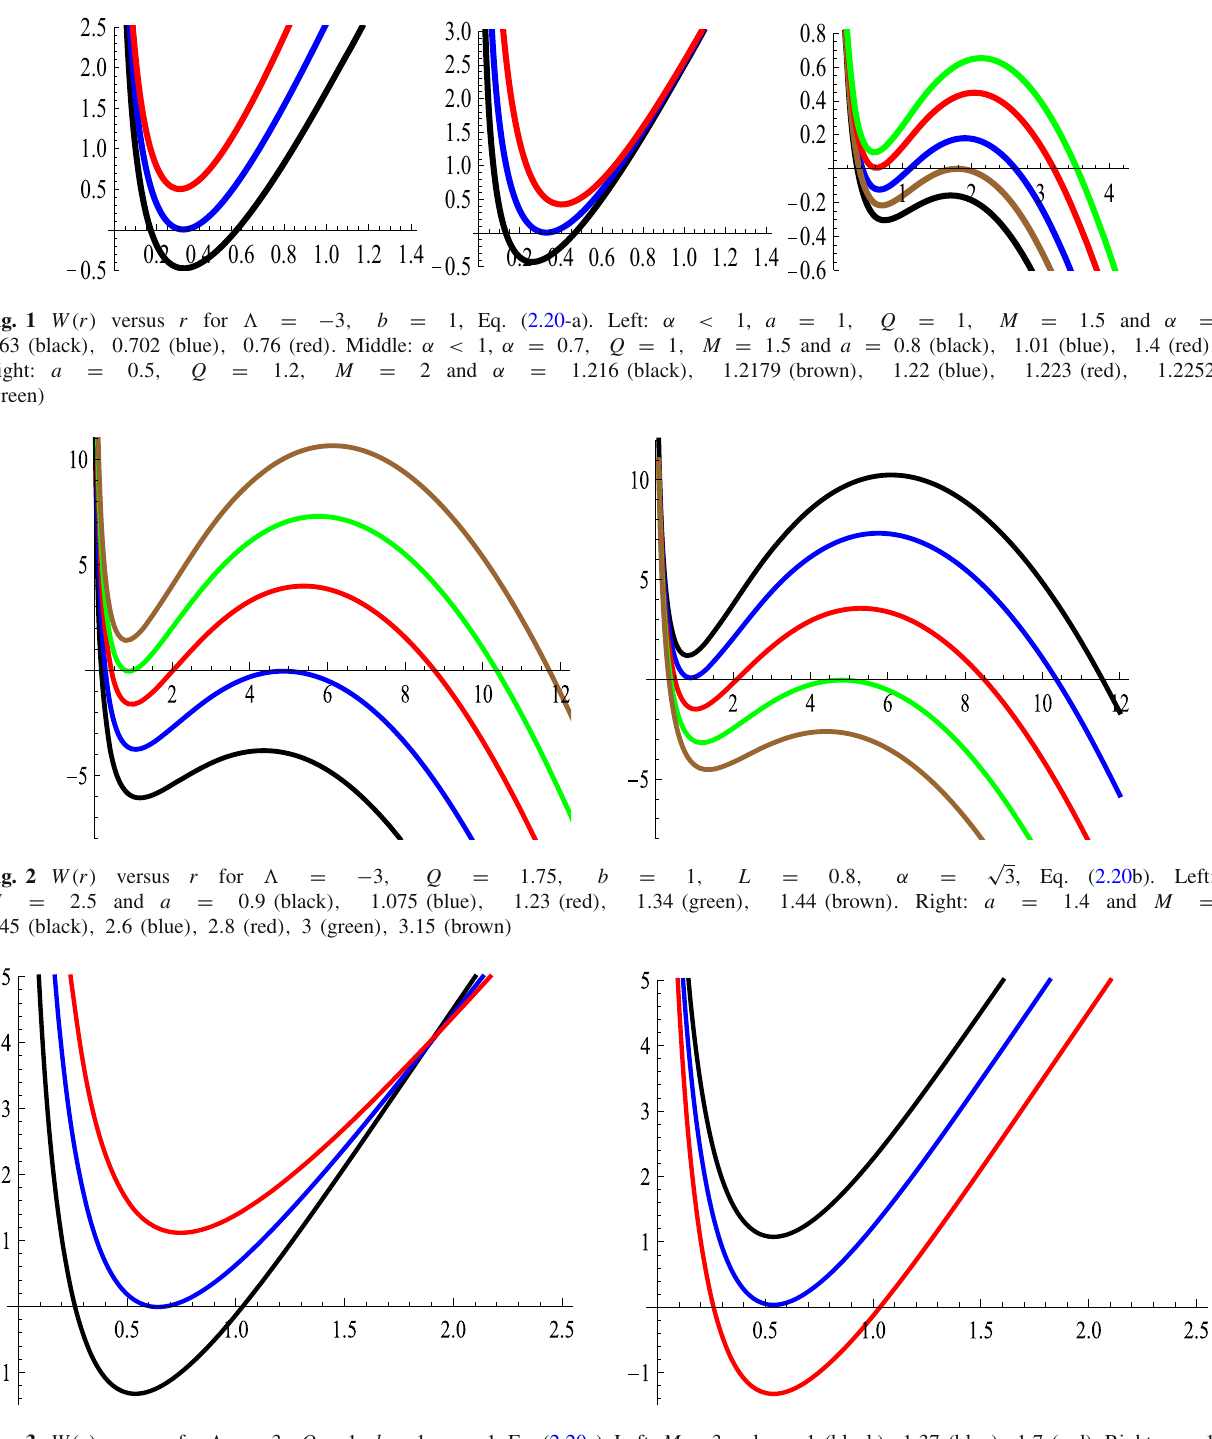
Fig. 3 W ( r ) versus r for (cid:11) = − 3 , Q = 1 , b = 1 , α = 1, Eq. (2.20c). Left: M = 3 and a = 1 ( black ), 1 . 37 ( blue ), 1 . 7 ( red ). Right: a = 1 and M = 2 . 4 ( black ), 2 . 66 ( blue ), 3 ( red